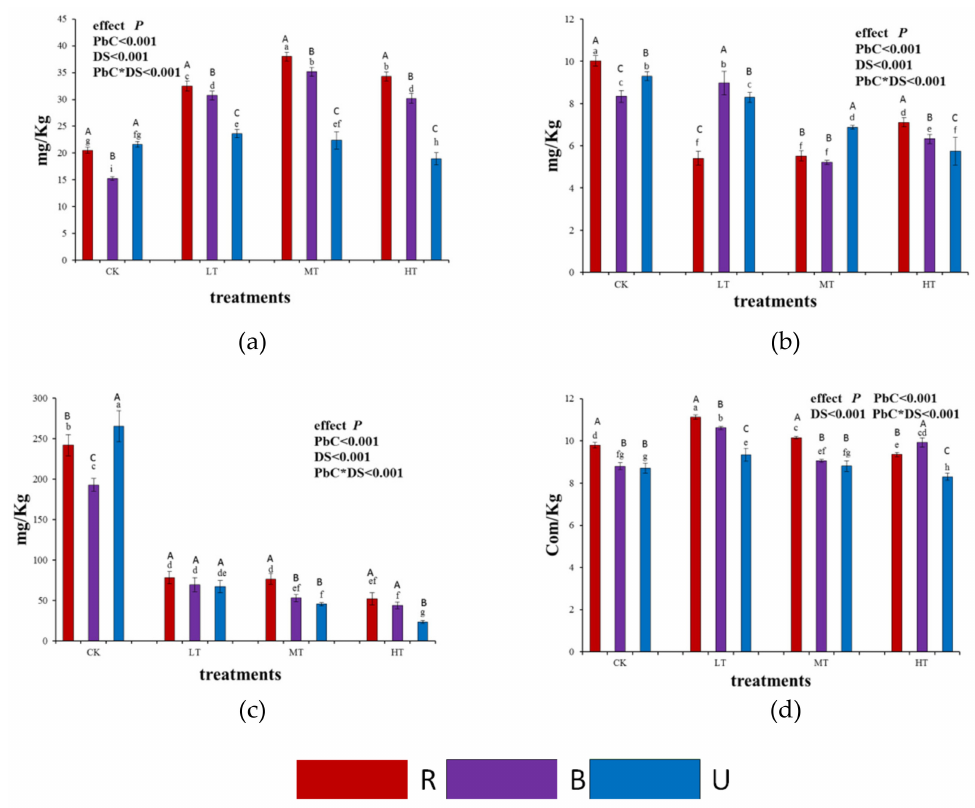
Figure 2. Soil properties of available nitrogen ( a ), available phosphorus ( b ), available potassium ( c ), and cation exchange capacity ( d ). No pollution (CK), 0 mg/kg; light pollution (LT), 500 mg/kg; medium pollution (MT), 1000 mg/kg; high pollution (HT), 1500 mg/kg; R, rhizospheric soil; B, bulk soil; U, unplanted soil. PbC, Pb concentration effect; DS, different sources of soil; PbC × DS, the interactive effect of Pb concentration and different sources of soil. Different letters indicate that values differ significantly at p < 0.05. The lowercase letters represent the global comparison and uppercase letters represent the intra-soil type comparisons. Values represent mean ± SD ( n =